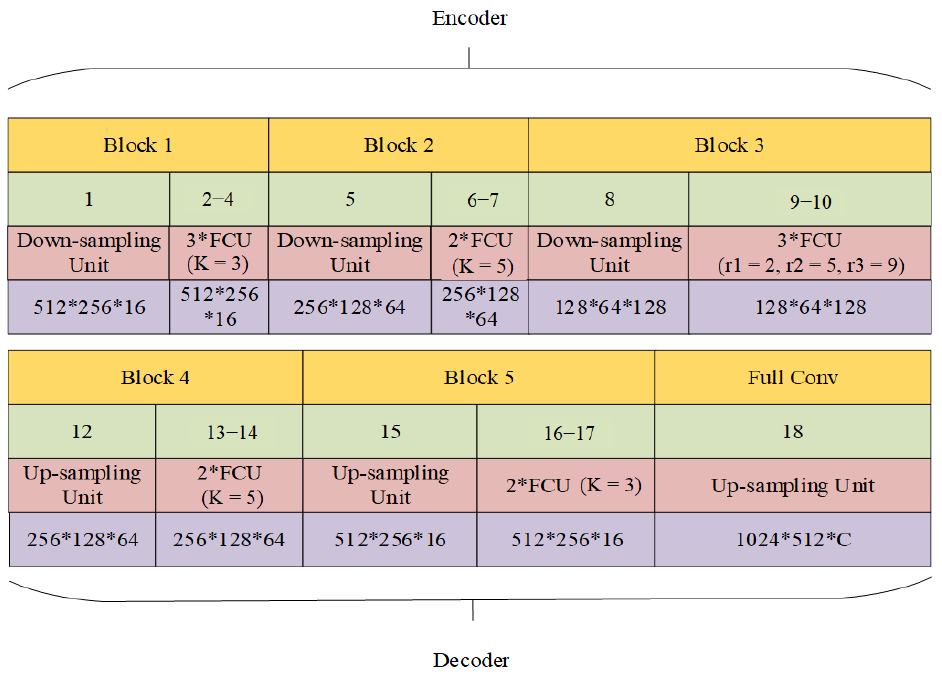
Figure 7. The structure level of ESNet.